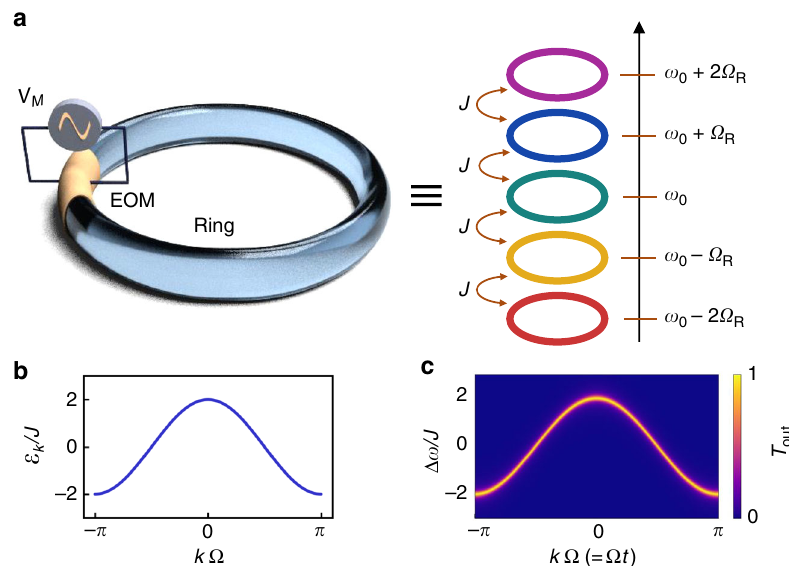
Fig. 1 Dynamically modulated ring cavity and its band structure in the synthetic frequency dimension. a A sinusoidal signal V M modulates the index of a part of the ring (left) at the mode spacing Ω R , creating coupling J between the different frequency modes (right). EOM electro-optic phase modulator. b Band structure of the nearest-neighbor coupled 1D tight-binding model, ε k = 2 J cos k Ω . c Theoretical time-resolved steady-state response of the ring (Eq. 16) for a cavity loss rate 2 γ = J /5. The time t plays the role of the Bloch quasimomentum k